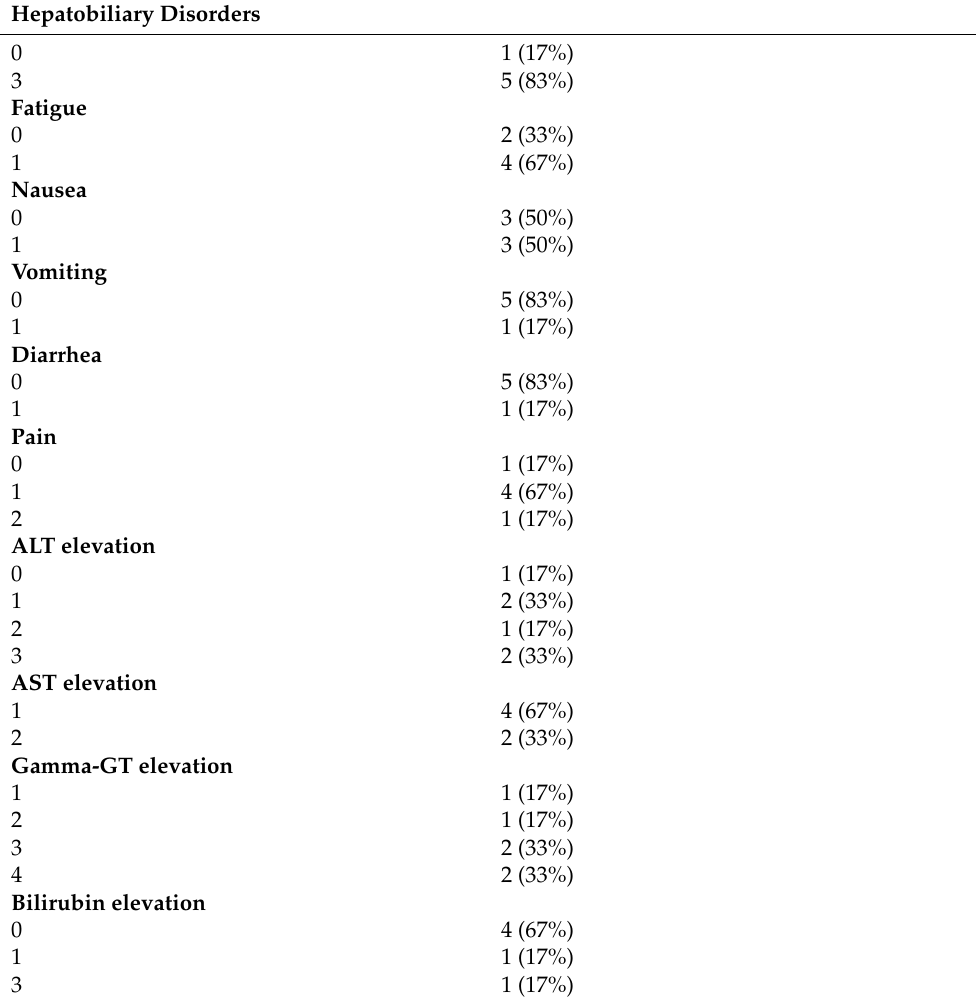
Table 6. Maximum grade toxicity (CTCAE v4.03) during